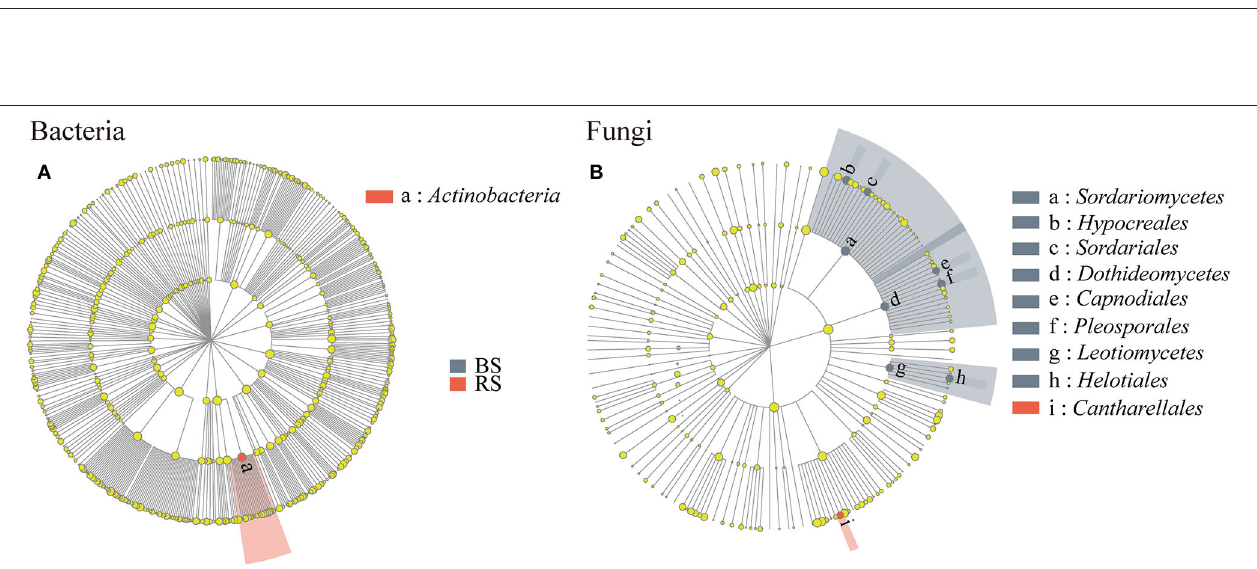
Frontiers in Microbiology |